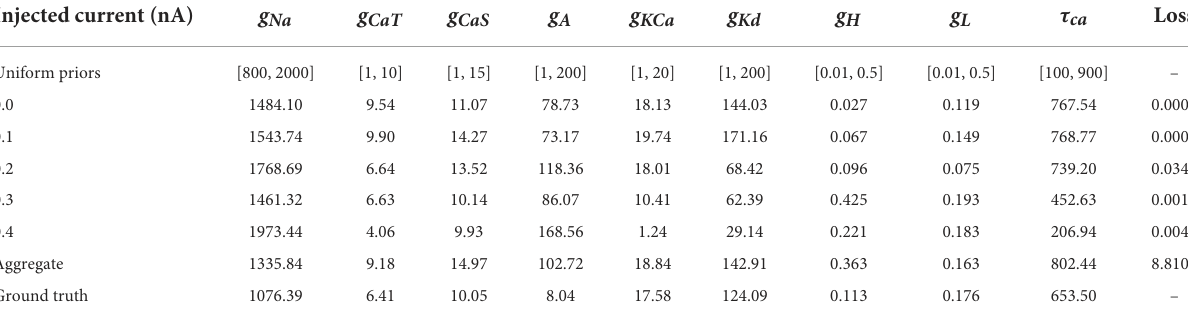
TABLE 2 Parameter sets for the lowest loss values calculated by the MCMC algorithm. Injected current